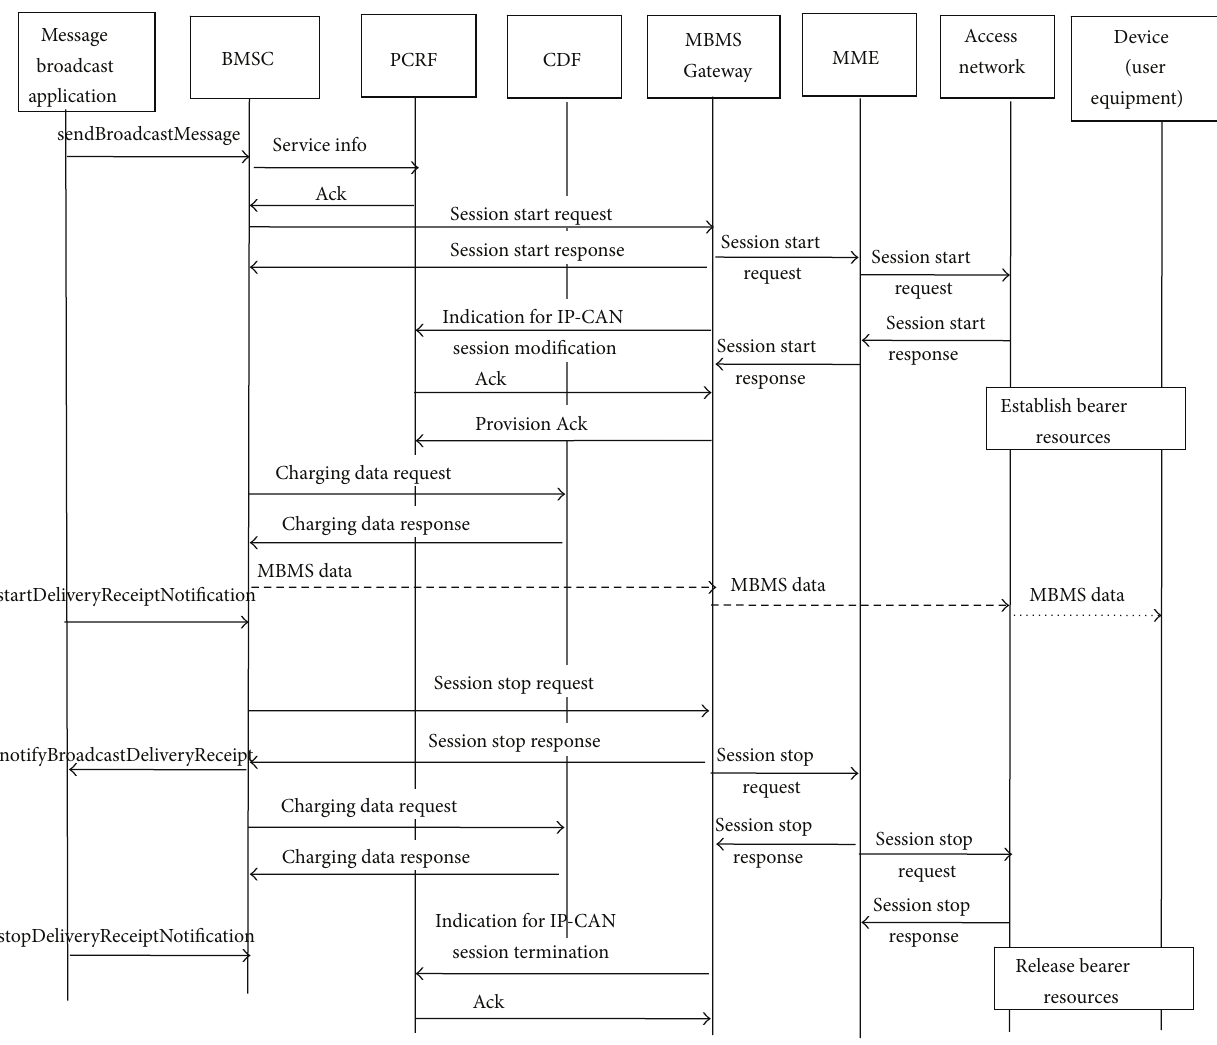
Figure 5: Typical message flow illustrating 3rd-party control of MBMS in the